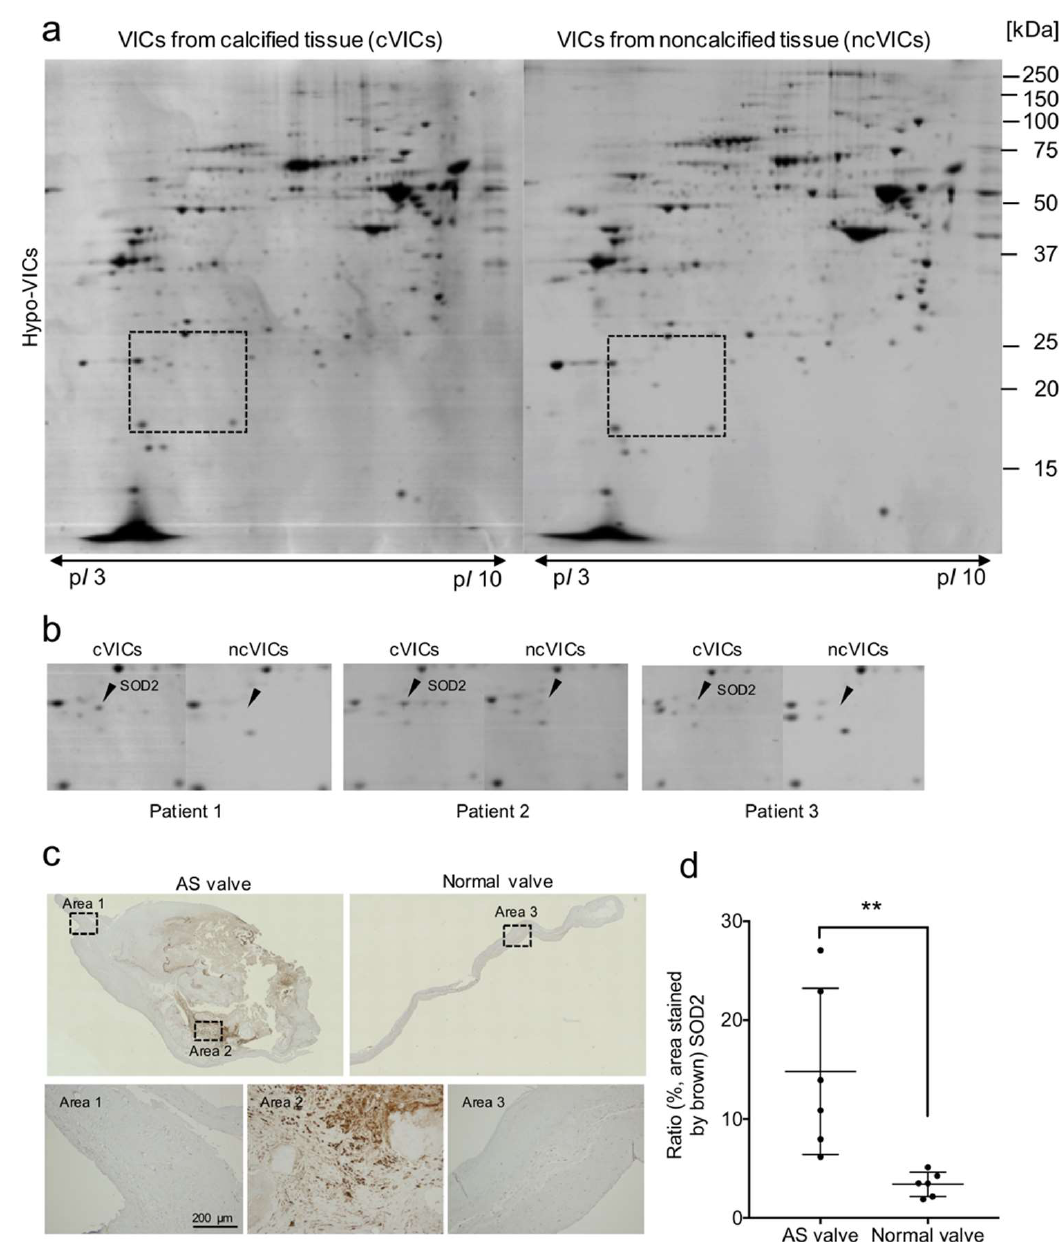
Figure 6. Expression of the oxidative stress marker SOD2 is increased in VICs from calcified AS tissues (cVICs). ( a ) 2DGE from lysates of cultured cVICs and ncVICs from patient 1. ( b ) Left panels, enlargements of the region surrounded by broken lines in ( a ) (patient 1). Middle and right panels show the same regions enlarged from 2DGE images of patients 2 and 3. ( c ) Immunohistochemical detection of SOD2 in AS and normal valves. Lower panels show enlarged views of areas 1–3 (boxes in upper panels). ( d ) Quantification of SOD2-stained areas; data are represented as means ± SE ( n = 6). **p < 0.01. Table 1. Summary of LC-MS/MS analysis of 21 kDa-protein spot.